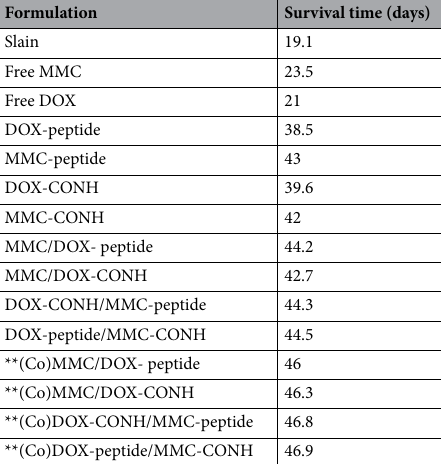
Formulation Survival time